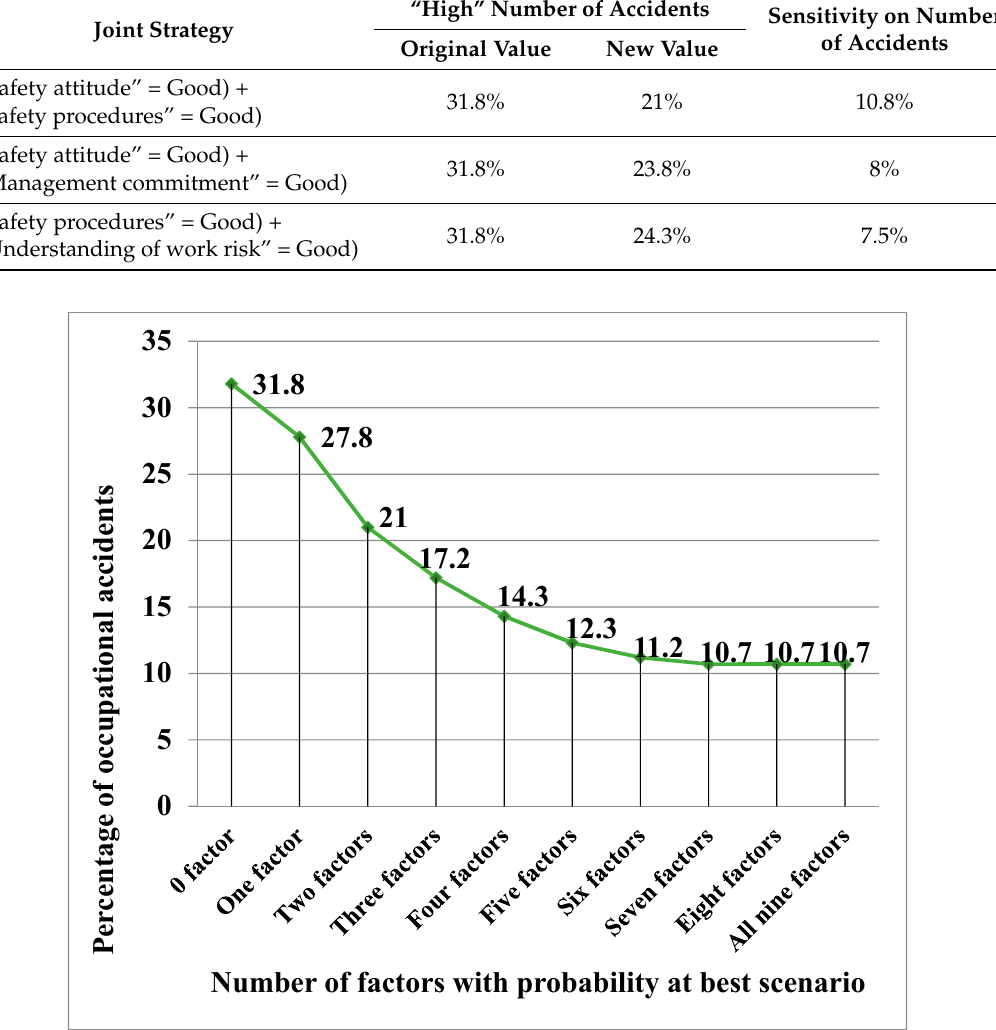
Table 6. Two-factor strategies with the highest effect to reduce the number of accidents.